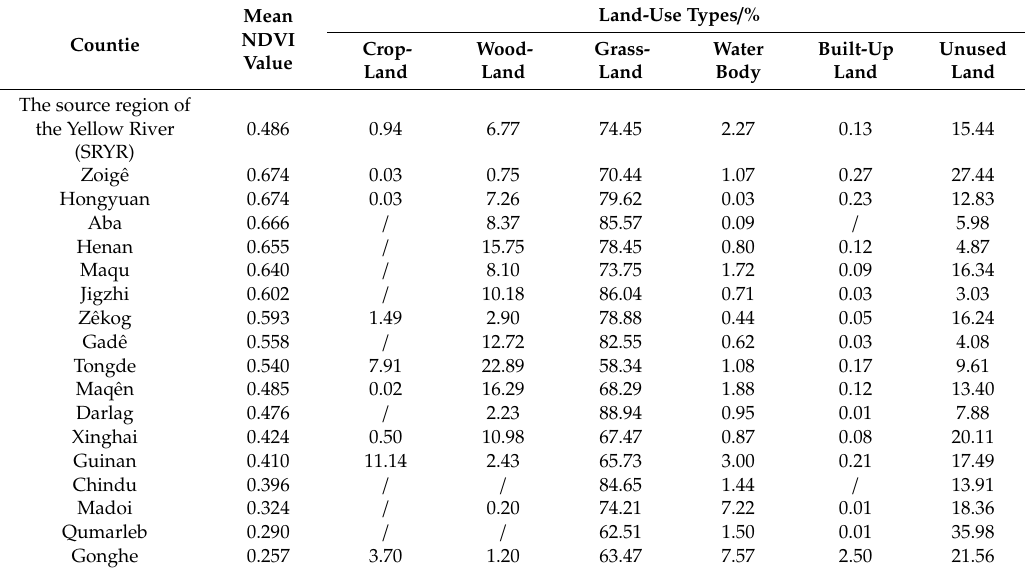
Table 1. Normalized Di ff erence Vegetation Index (NDVI) value and proportion of land-use types in di ff erent